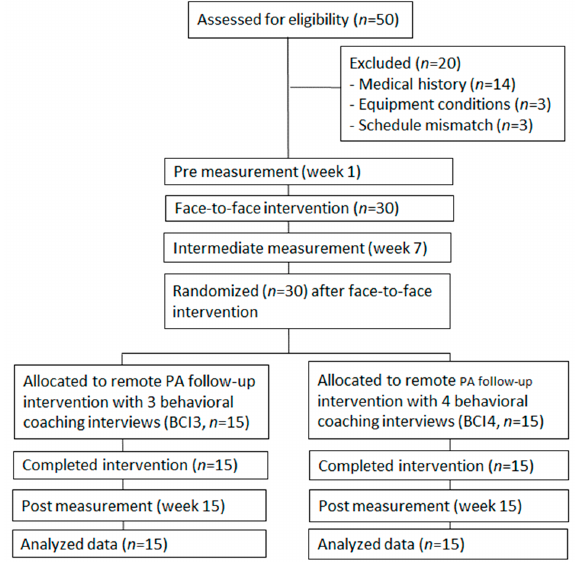
Figure 1. Study flow.